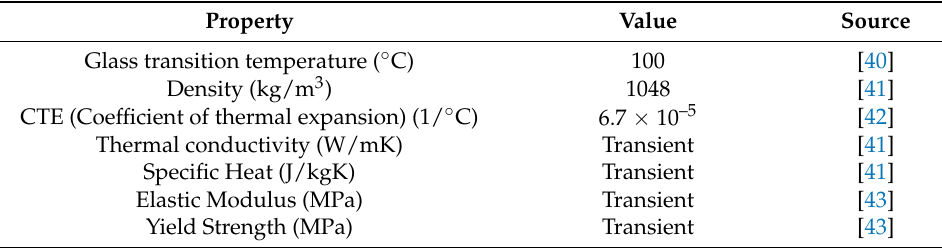
Table 11. Material properties for HIPS material.